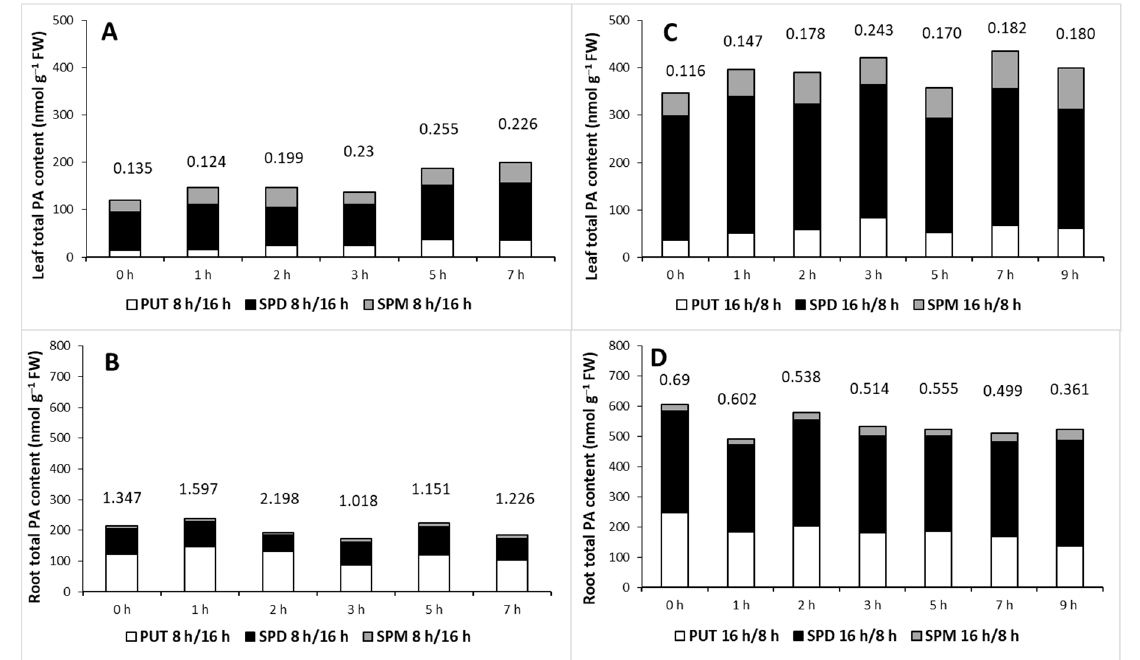
Figure 2. Effect of hours of illumination on the polyamine (PA) content in the leaves ( A , C ) and roots ( B , D ) of plants grown under 8 h/16 h ( A , B ) or 16 h/8 h ( C ,D) day/night light period. PUT: putrescine, SPD: spermidine, SPM: spermine. Data represent mean values ± SD. Numbers indicate the ratio of PUT/(SPD + SPM).